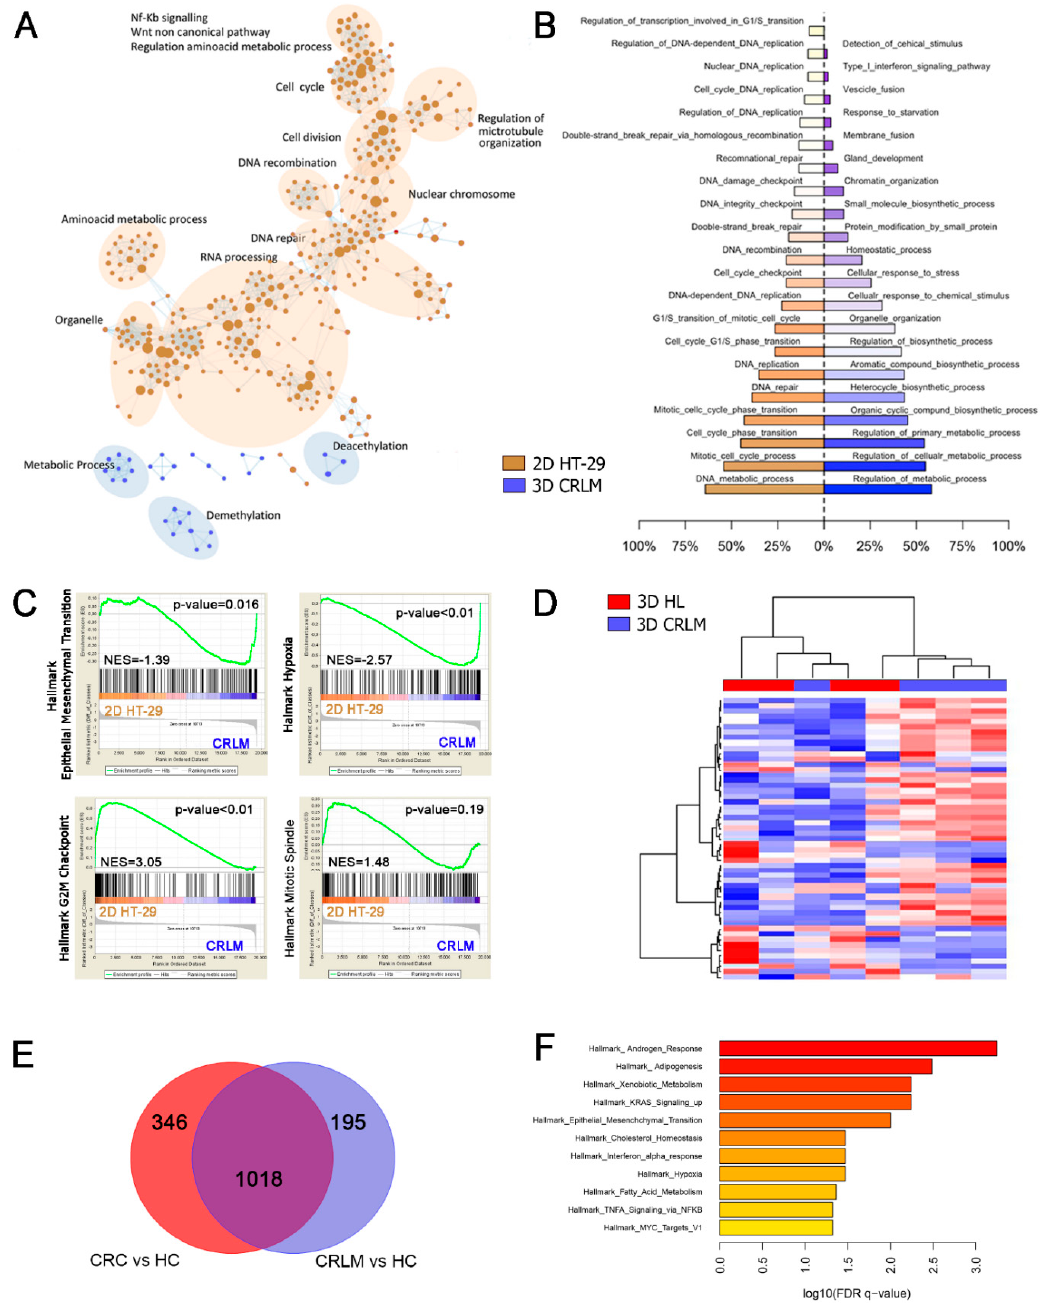
Figure 5. Global gene expression analysis of HT-29 cells in 2D and in HL and CRLM 3D culture models. ( A ) Enriched biological process in recellularized CRLM scaffolds ( n = 4), after 10 days of growth (blue) and in HT-29 cells grown in 2D (brown) using gene ontology MSigDB. ( B ) Parallel analysis of the most enriched biological processes in recellularized CRLM scaffolds, after 10 days of growth (blue) and in HT-29 cells grown in 2D (brown), using the SAM identified differently expressed genes. ( C ) Comparison of the differently expressed genes between recellularized CRLM scaffolds and HT-29 cells grown in 2D with an a-priori defined gene-set called Hallmark. Epithelial_Mesenchymal_Transition and Hypoxia are biological pathways enriched in recellularized CRLM scaffolds, while G2M_Checkpoint is enriched in HT-29 cells grown in 2D. The horizontal bar displaying a graded color from brown (left) to blue (right) represents the genes list ranked from high expression in the HT-29 cells grown in the 2D